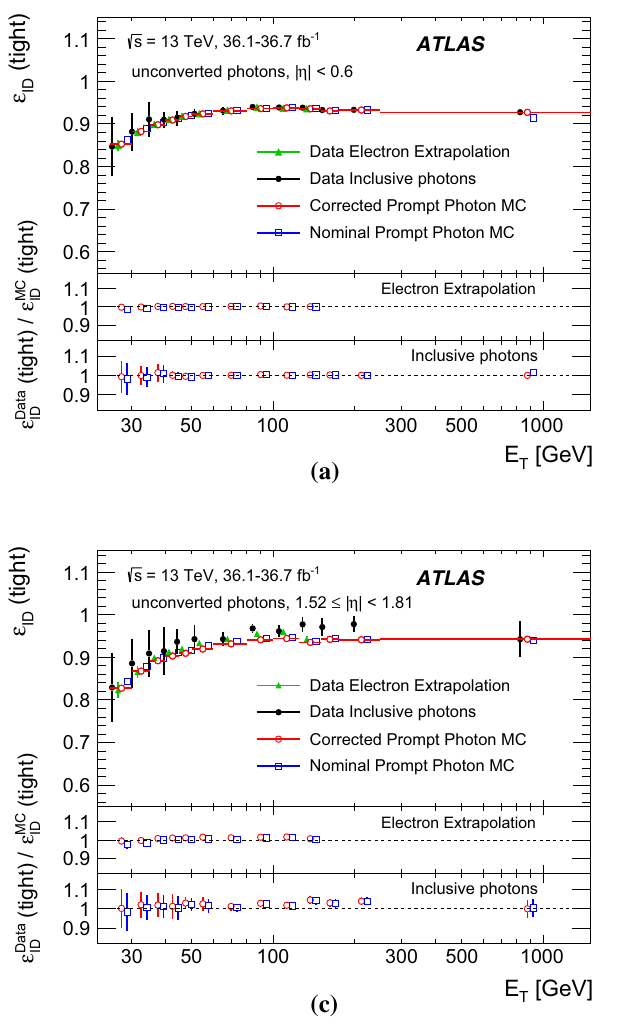
Fig. 11 Comparison of the measurements of the data-driven identifi- cation efficiency for unconverted photons obtained using the electron extrapolation and inclusive photon methods with the predictions from prompt-photon + jet simulation as a function of photon E T , for the four pseudorapidity intervals a | η | < 0 . 6, b 0 . 6 ≤ | η | < 1 . 37, c